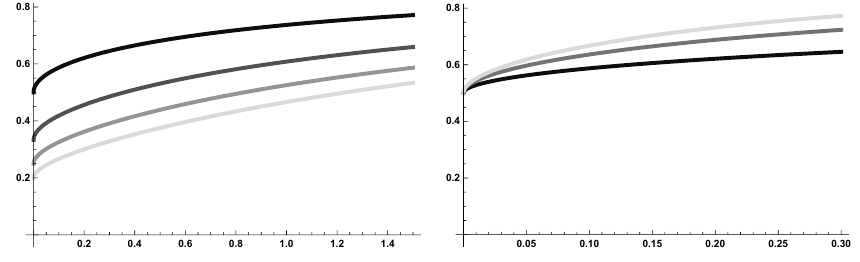
Figure 1. On the ( left ), solutions of the logistic equation C D β u − u = − u 2 (on the left ) with β = 1/2 and u 0 = 1/2,1/3,1/4,1/5; darker lines correspond to bigger u 0 s. On the ( right ), solutions of the logistic equation C D β u − u = − u p + 1 with β = u 0 = 1/2 and p = 1,2,3; darker lines correspond to bigger p